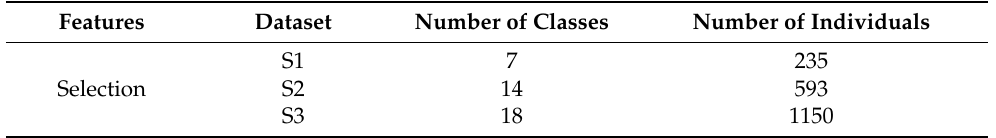
Table 3. Features of the generated query